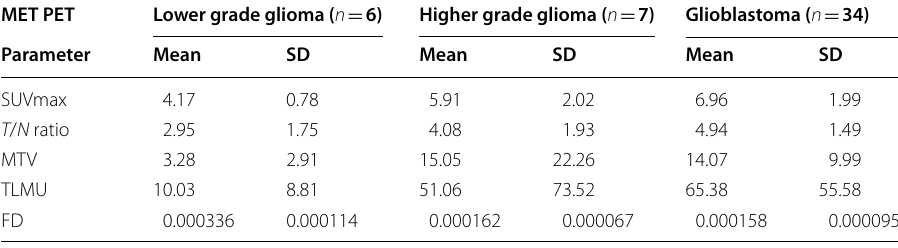
Table 3 MET PET findings in patients with newly diagnosed gliomas according to the glioma group MET PET